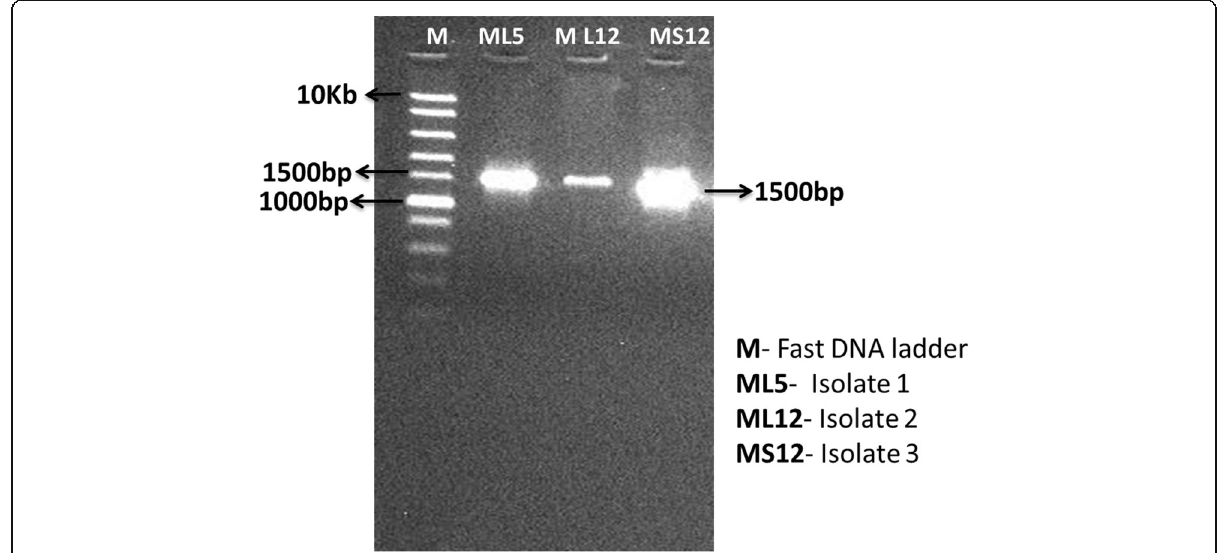
Fig. 5 PCR amplification product of bacterial Genomic DNA from selected bacterial isolates. Electrophoresis was performed on a 1.2% Agarose gel stained with gel